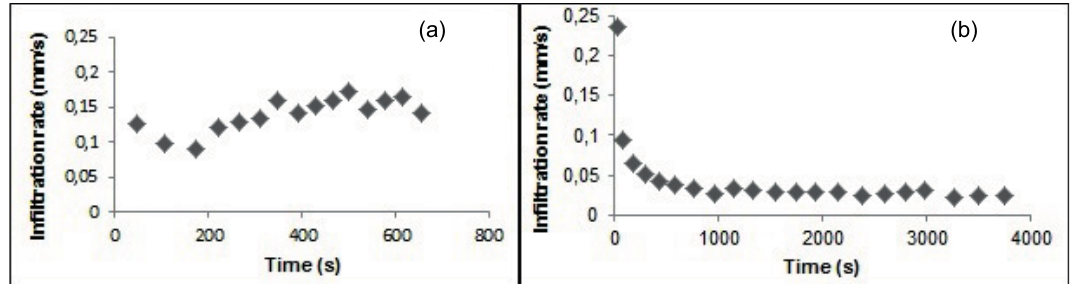
Fig. 2 Infiltration curve behaviour: (a) transient state and (b) steady